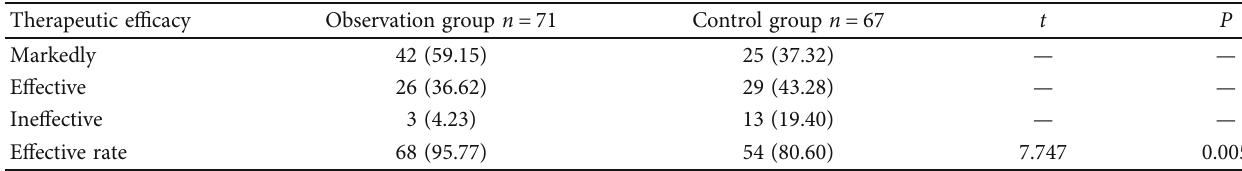
Table 2: Comparison of therapeutic e ffi cacy between the two groups.